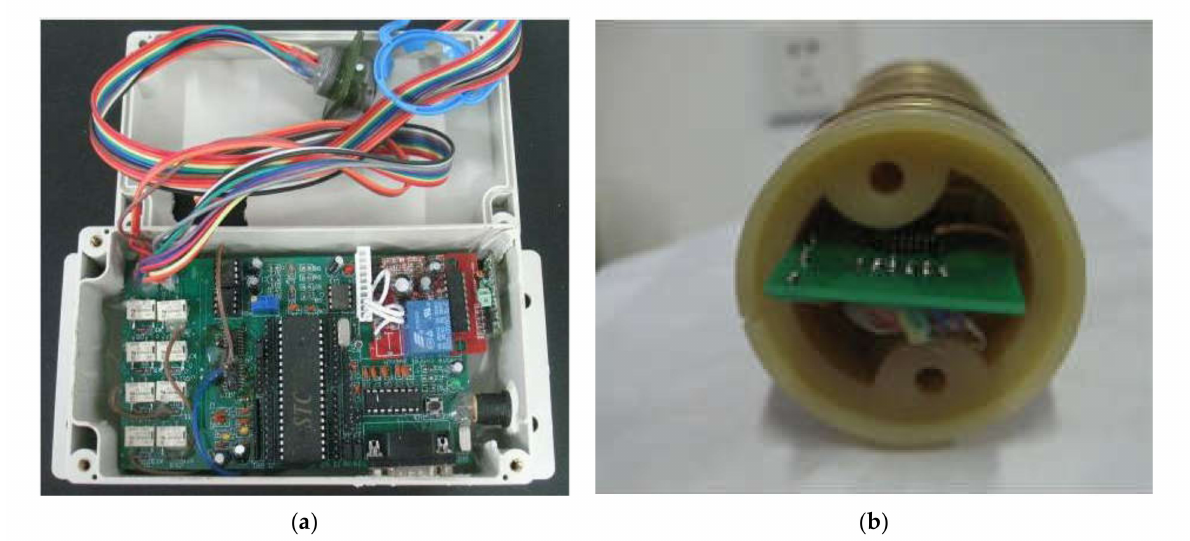
Figure 9. Actual instrument: main control circuit ( a ); distributed circuit ( b